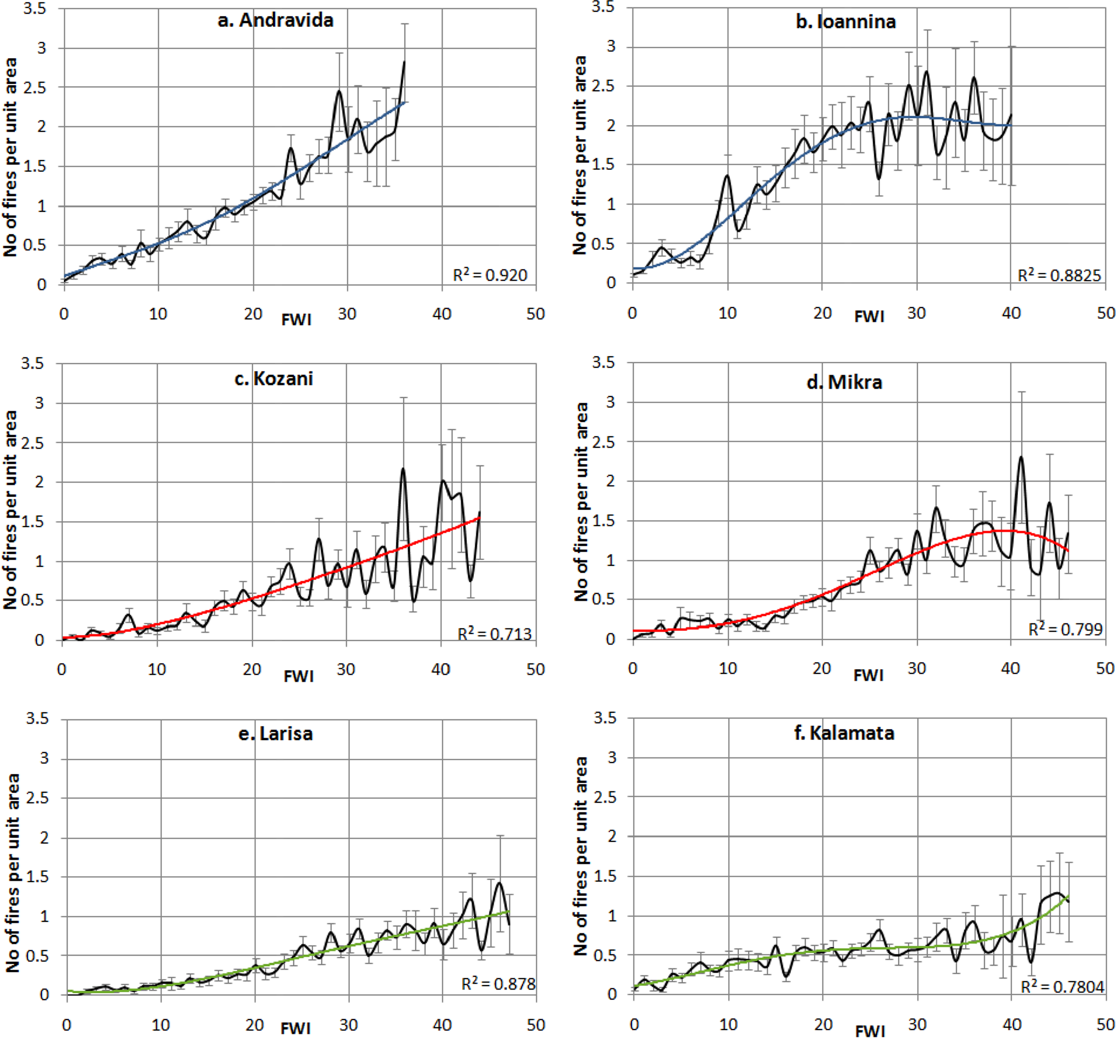
Fig. 4. Mean number of fires per unit area and per day against FWI and the respective polynomial fit for two indicative stations for each category of different FWI behaviour: (a) Andravida and (b) Ioannina in WG, (c) Kozani and (d) Mikra in NG, and (e) Larisa and (f) Kalamata in EG/SG for the 1983–1997 period. The error bars correspond to the standard error of each